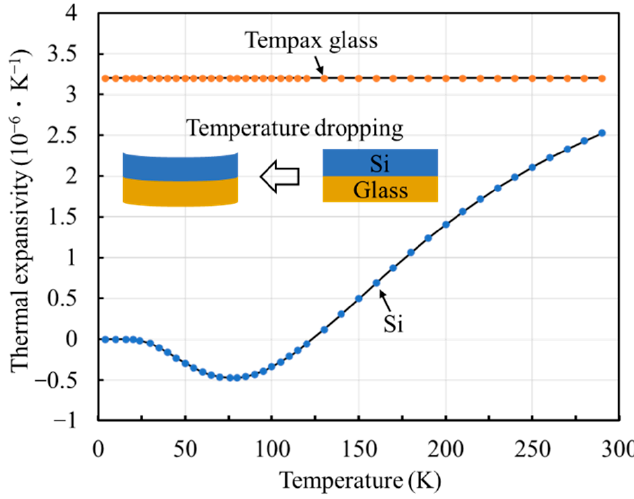
Figure 10. Comparison of thermal expansion coefficients between Si and Tempax glass. (Inset shows the deformation of the heterogeneous structure of Si bonded onto glass with decreased tempera- ture.).